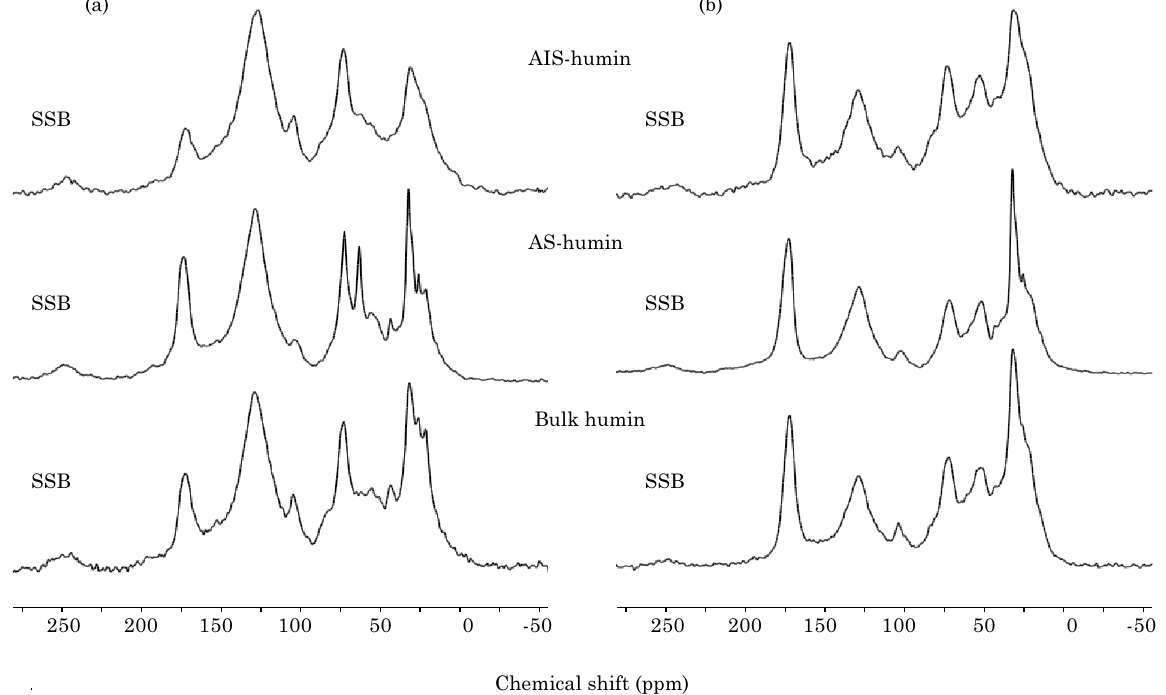
figure 1. solid-state 13 C CPmas nmr spectra of bulk humin and its corresponding alkaline-soluble humin (as-humin) and alkaline-insoluble humin (ais-humin) from luvic Phaeozem (a) and hapic Chernozem (b) (ssb = spinning side